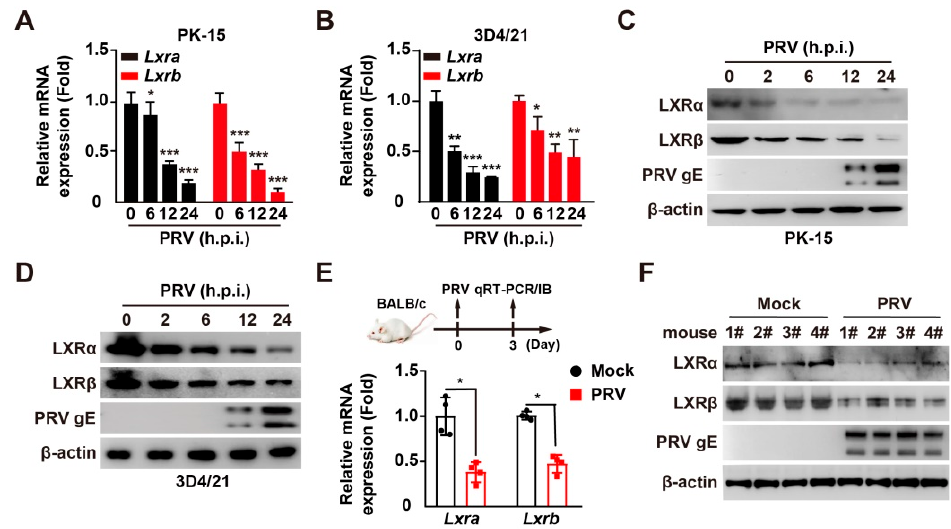
Figure 1. PRV infection downregulates LXR expression. ( A , B ) PK-15 ( A ) and 3D4/21 ( B ) cells were infected with PRV-QXX (MOI = 0.1) for 0–24 h. The mRNA levels of Lxra and Lxrb were assessed by qRT-PCR analysis. * p < 0.05, ** p < 0.01, *** p < 0.001. ( C , D ) PK-15 ( C ) and 3D4/21 ( D ) cells were infected with PRV-QXX (MOI = 0.1) for 0–24 h. LXR α , LXR β , and PRV gE were assessed by immunoblotting analysis. ( E ) Mice were mock infected or intranasally infected with PRV-QXX (5 × 10 3 TCID 50 /50 μ L per mouse) for 3 days. The mRNA levels of Lxra and Lxrb in the lung were assessed by qRT-PCR analysis ( n = 4 per group). * p < 0.05. ( F ) Mice were treated as in G . LXR α , LAR β , and PRV gE in the lung were assessed by immunoblotting analysis ( n = 4 per group).